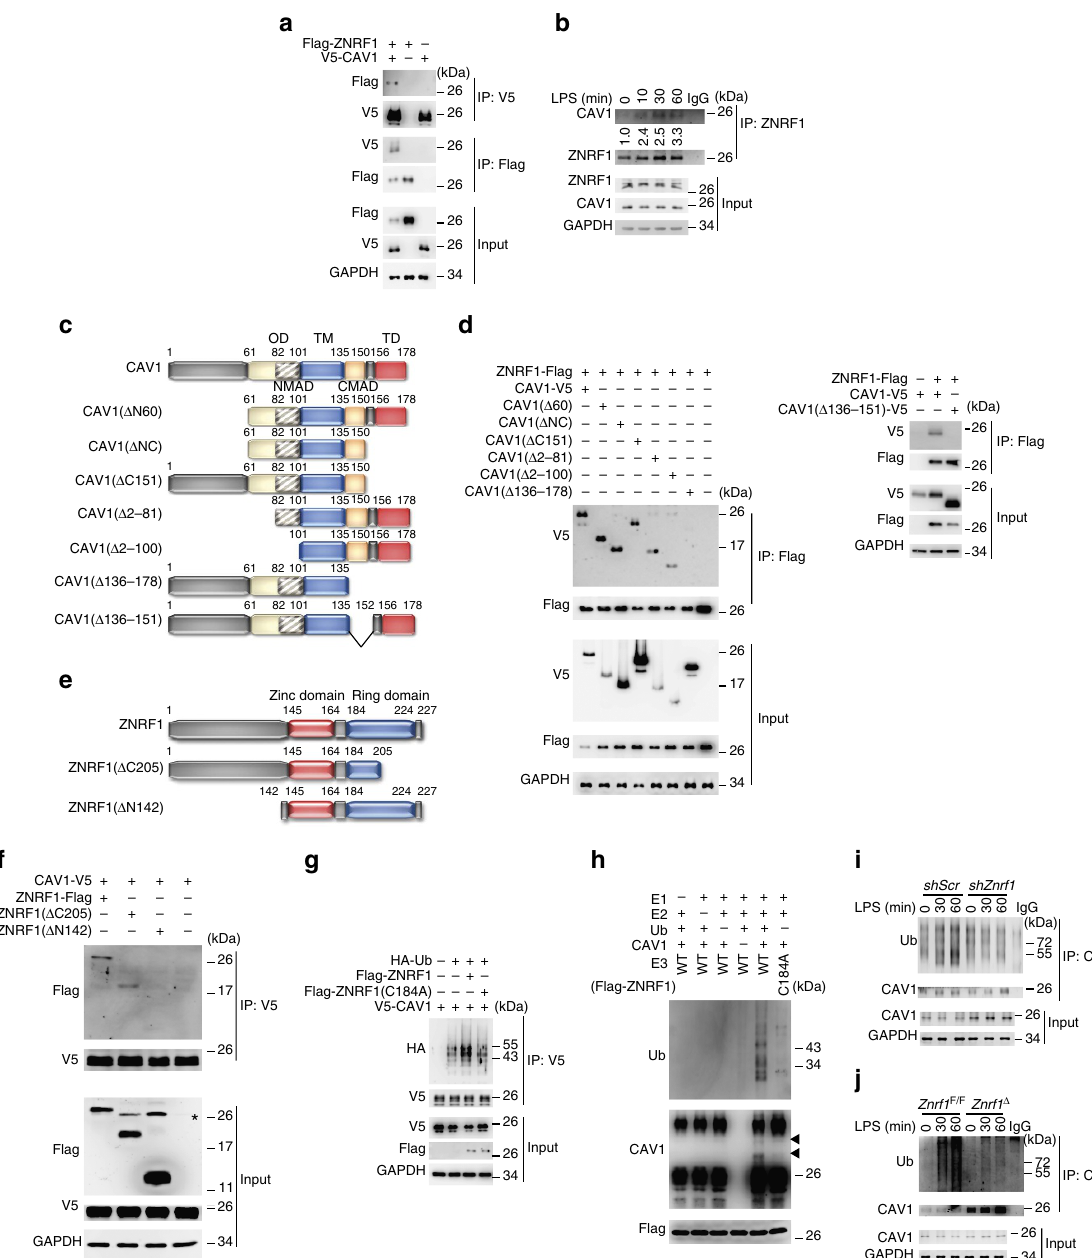
Figure 4 | ZNRF1 interacts with CAV1 and promotes CAV1 ubiquitination in response to LPS. ( a ) HEK293T cells were co-transfected with V5-tagged CAV1 and Flag-tagged ZNRF1 as indicated. Interactions between ZNRF1 and CAV1 were detected by immunoprecipitation followed by immunoblot analysis with the indicated antibodies. ( b ) Immunoprecipitation of ZNRF1 from lysates of RAW264.7 cells treated with LPS (100ngml (cid:2) 1 ) for the indicated times, followed by immunoblot analysis with the indicated antibodies. The intensities of the bands are shown as fold increases compared to those of untreated cells after normalization to ZNRF1 level. ( c ) Schematic diagram of full-length CAV1 and six truncated forms of CAV1 with a C-terminal V5 tag. ( d ) HEK293T cells were co-transfected with Flag-tagged ZNRF1 and V5-tagged full-length or truncated CAV1 as indicated, and interactions between CAV1 and ZNRF1 were identified by immunoprecipitation and immunoblotting with the indicated antibodies. ( e ) Schematic diagram of full-length ZNRF1 and two truncated forms of ZNRF1 with a C-terminal Flag-tag. ( f ) HEK293Tcells were co-transfected with V5-tagged CAV1 and Flag-tagged full-length or truncated form of ZNRF1 as indicated, and interactions between CAV1 and ZNRF1 were identified by immunoprecipitation and immunoblotting with the indicated antibodies. ( g ) HEK293T cells were co-transfected with Flag-tagged ZNRF1 or ZNRF1(C184A) mutant and V5-tagged CAV1 and HA-tagged ubiquitin. CAV1 ubiquitination was determined by immunoprecipitating V5-tagged CAV1 and subsequent immunoblotting with anti-HA. ( h ) In vitro ubiquitination assays were carried out with bacterially expressed His-CAV1, ZNRF1 or ZNRF1(C184A), purified ubiquitin catalytic components as indicated. The mixtures were then subjected to immunoblotting with the indicated antibodies. Arrows indicate Ubiquitin-conjugated CAV1. ( i , j ) RAW264.7 cells transduced with lentiviruses expressing shScr or shZnrf1 and BMDMs from Znrf1 F/F and Znrf1 D mice were treated with LPS (100ngml (cid:2) 1 ) for the indicated times after MG132 pre-treatment. CAV1 ubiquitination was determined by immunoprecipitating CAV1 and subsequent immunoblotting with anti-ubiquitin antibody. The data are representative of three independent experiments performed in